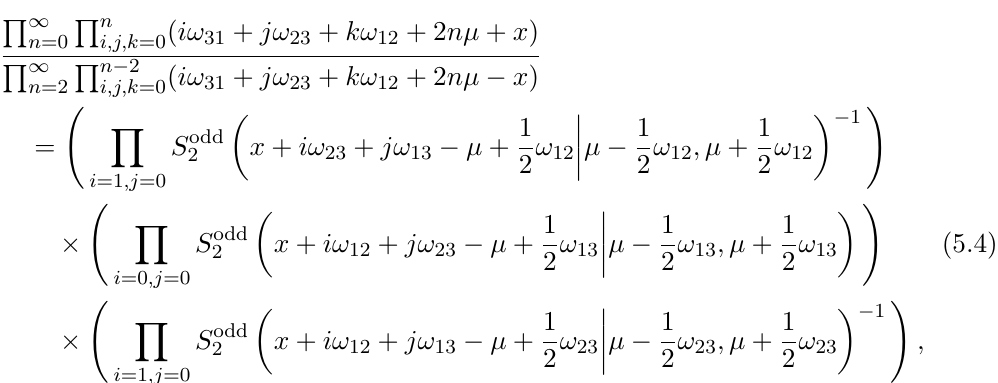
Figure 4 . Cartoons illustrating the di(cid:11)erent factorisation results for S 7 and S . the special function in